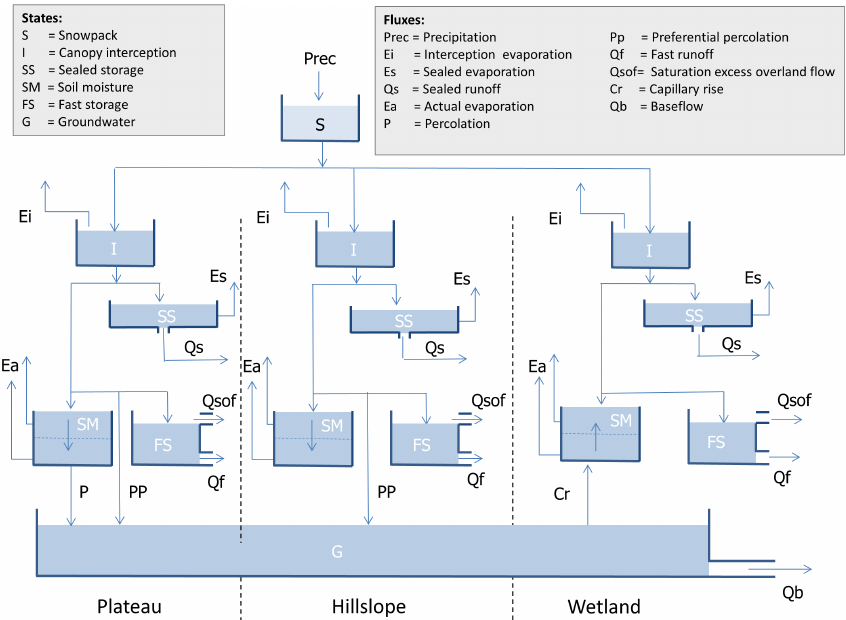
Figure 3. The mHMtopo model structure with different configurations of states and fluxes for landscape classes plateau, hillslope, and wetland, which are based on topography. First, a shared snow module (S) divides the effective precipitation over the landscape classes. The three classes all have an interception module (I), a fast reservoir accounting for sealed areas (SS), a soil moisture routine (SM) and a fast reservoir (FS). The plateau landscapes are assumed to feed the groundwater through percolation (P) from the soil moisture and preferential percolation (PP). The steeper hillslope areas are assumed to merely feed the groundwater through preferential percolation (PP), whereas the wetlands receive water through capillary rise (Cr). The baseflow is determined by a shared groundwater